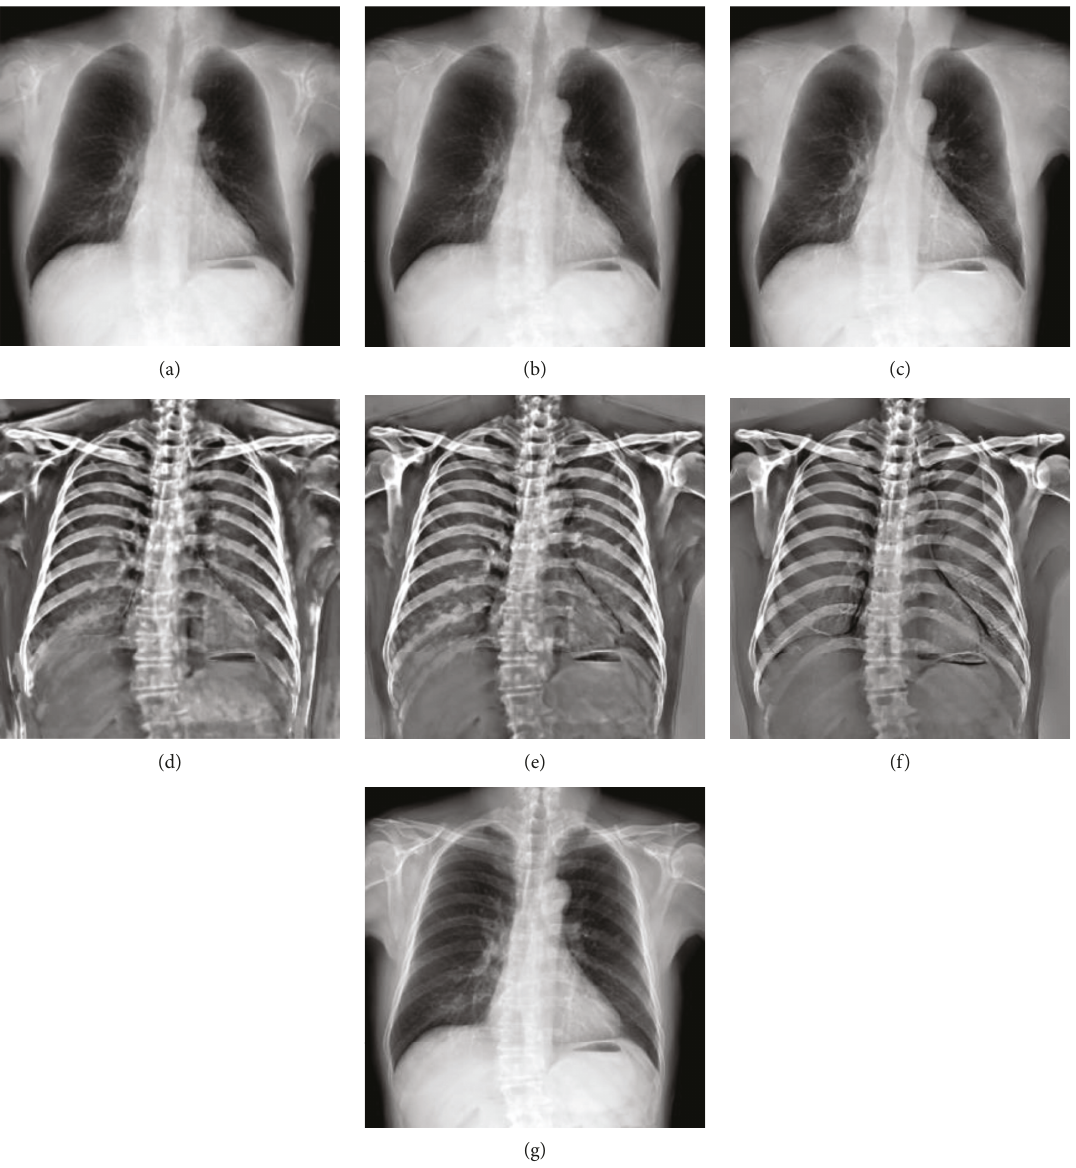
Figure 12: Comparison of the decomposition results through the MAP model and the locally weighted regression method: (a) the reconstructed soft tissue image through the locally weighted method; (b) the decomposed soft tissue image through the MAP model; (c) the DES soft tissue image of (g); (d) the reconstructed bone image through the locally weighted method; (e) the decomposed bone image through the MAP model; (f) the DES bone image of (g); (g) the standard chest